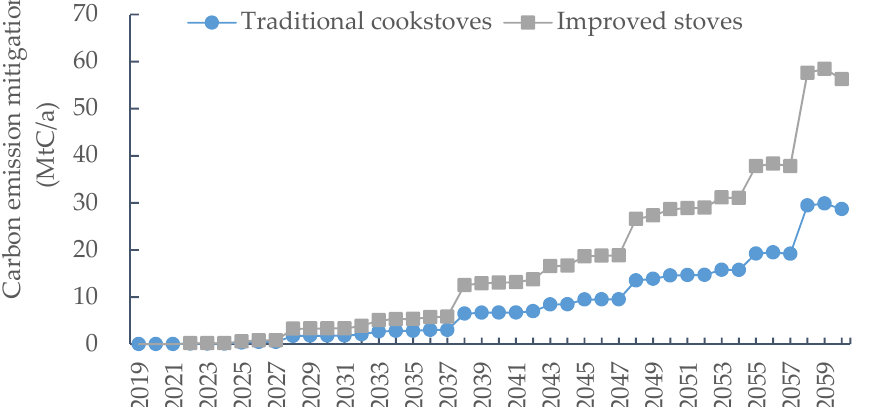
Figure 6. Carbon emission mitigation by forestry bioenergy of new planted commercial forest.